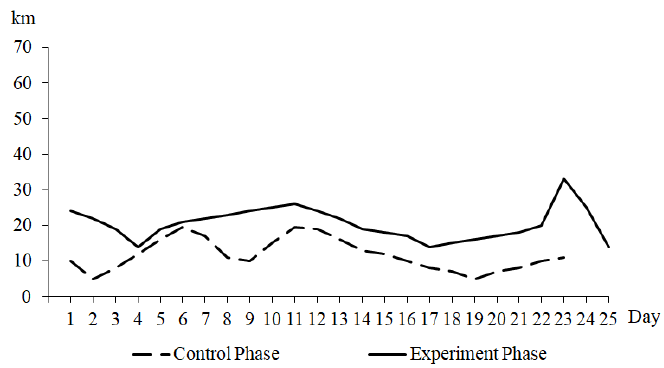
Figure 2. The dynamics of skiing load intensity.